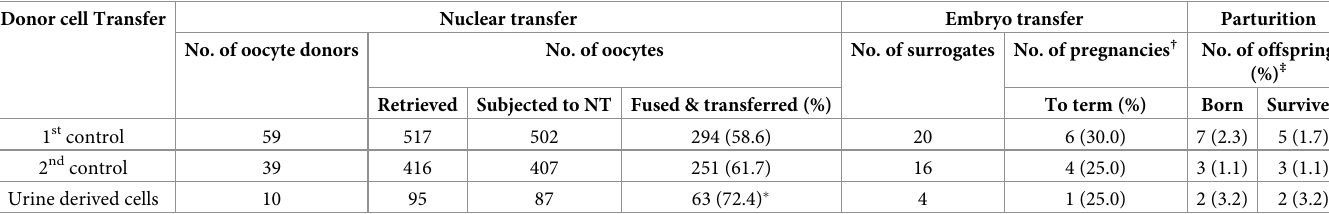
Table 1. Canine cloning comparison and syngeneic cloning attempts utilizing cells obtained from biopsies compared with urine derived cells. Donor cell Transfer